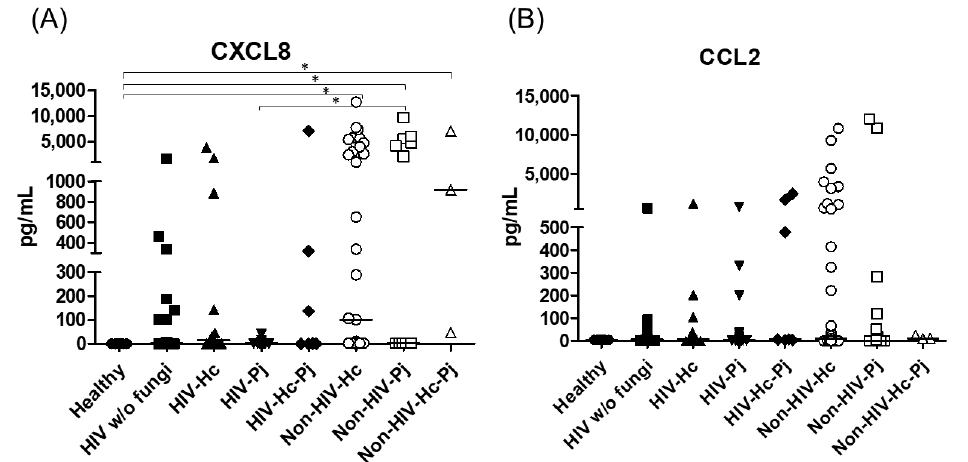
Figure 8. Determination of CXCL8 and CCL2 chemokines. These cytokines were detected by a cytometric bead assay in the BAL samples of hospitalized patients; results were obtained in pg/mL. Median values are shown for ( A ) CXCL8, and ( B ) CCL2. * p < 0.05.